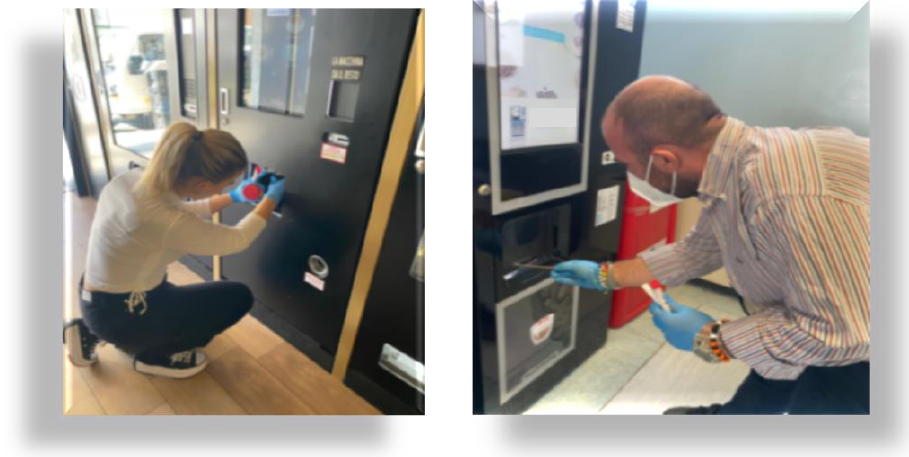
Figure 1. Healthcare professionals sampling internal and external surfaces of FVMs.